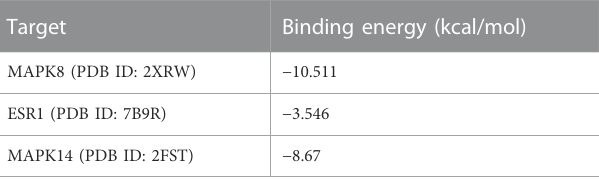
TABLE 2 Results of molecular docking of LPK to potential targets of network